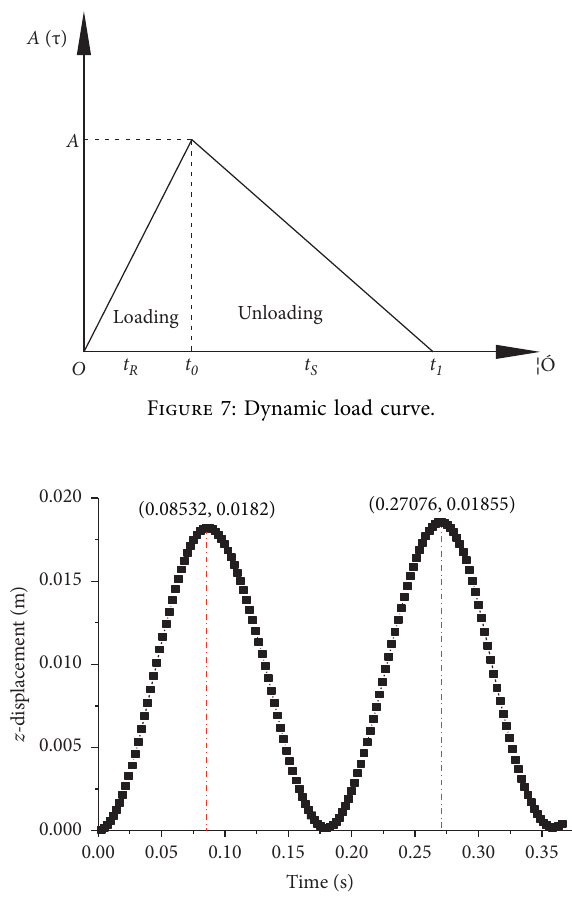
Figure 8: Overall view of the numerical simulation model. Table 2: Dynamic